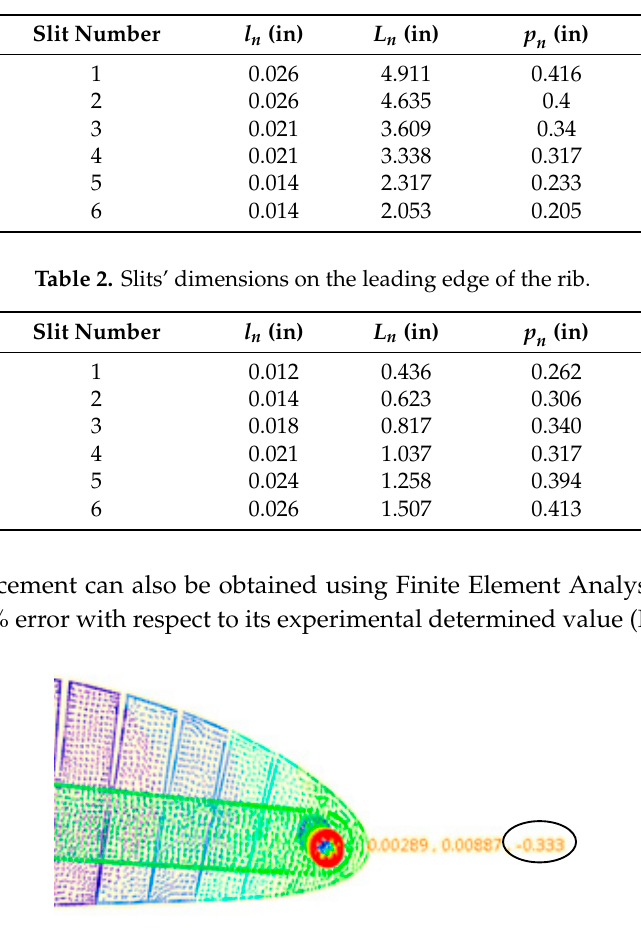
Figure 3. MLE tip maximum displacement of 0.333 in (8.46 mm).